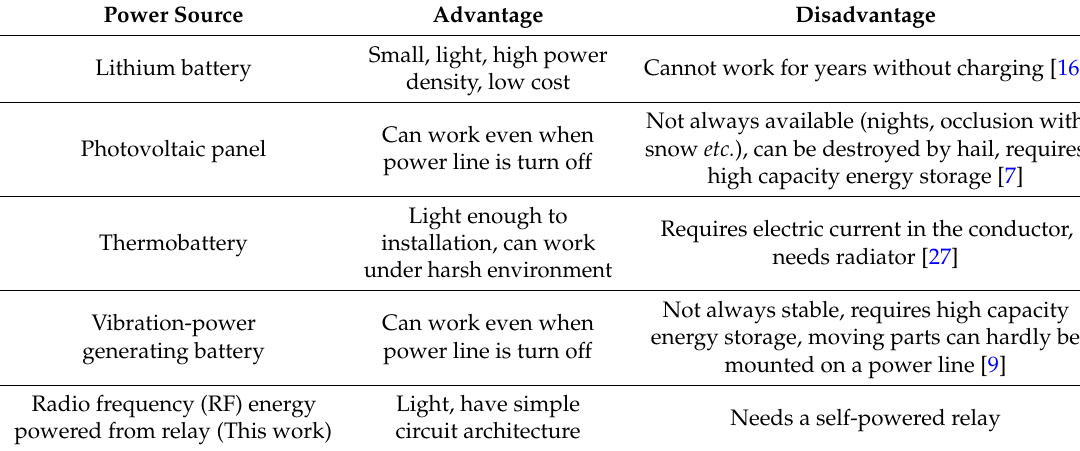
Table 1. Comparison of different power sources of radio frequency identification (RFID) tags on power